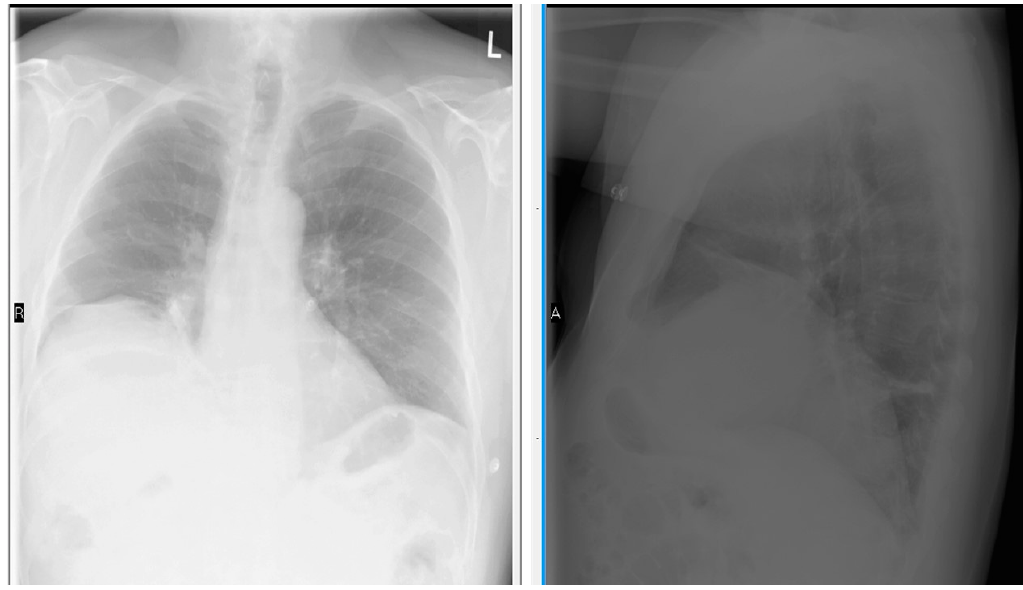
Figure 3. Chest X-ray Posterior-Anterior and Lateral view showing right diaphragm located more than 2 intercostal spaces compared to left side.